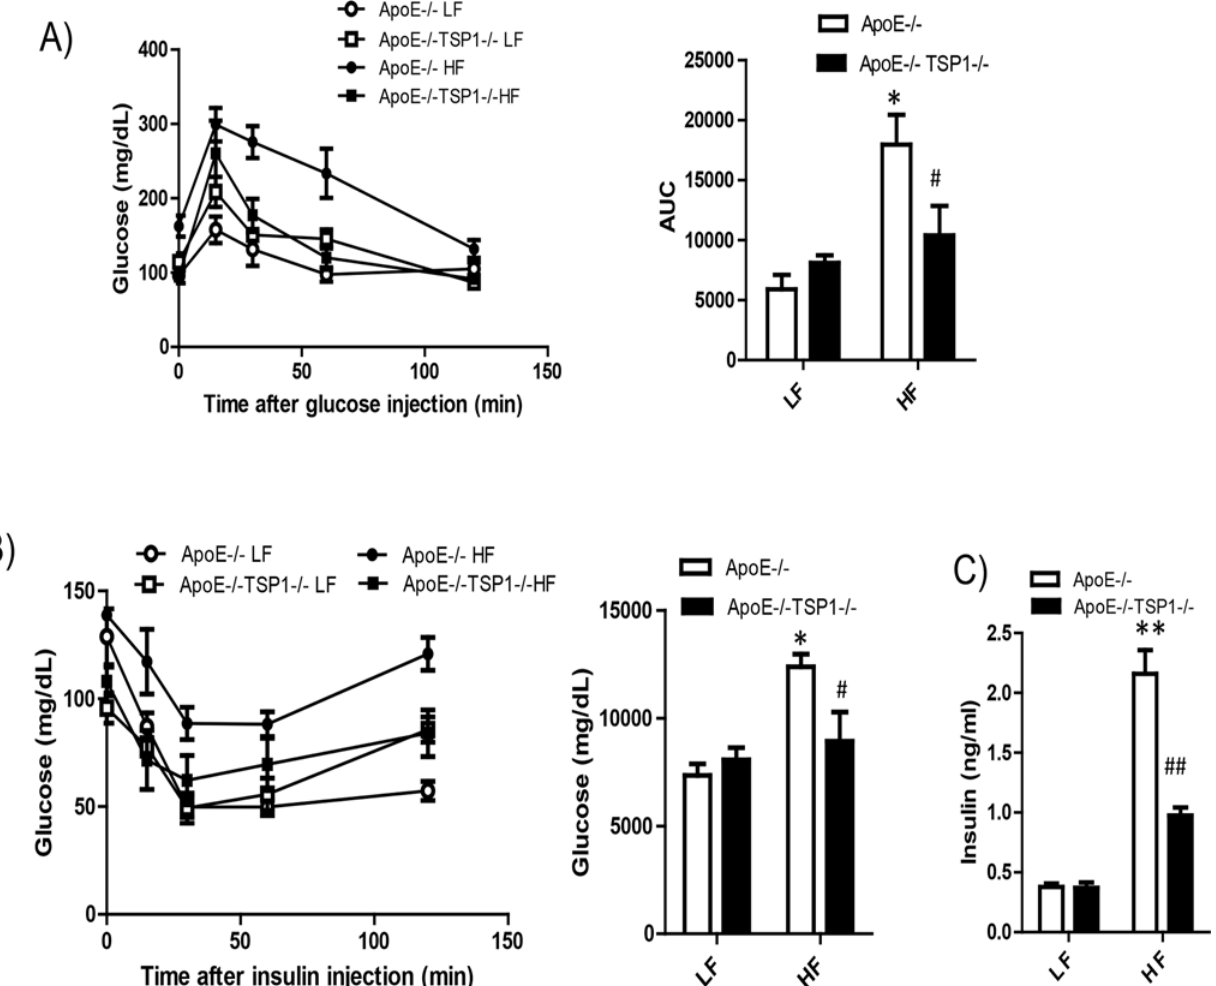
Fig 2. Obese ApoE-/-TSP1-/- mice had improved glucose tolerance and insulin sensitivity. Male ApoE-/-TSP1-/- mice and ApoE-/-mice were fed LF or HF diet for 16 weeks. Intraperitoneal glucose tolerance (A) and insulin tolerance test (B) were measured. Changes in blood glucose levels were monitored over time. C) Plasma insulin levels were measured by ELISA. Data are represented as mean ± SE (n = 10 mice/group). * P < 0.05 and ** P < 0.01 vs. LF ApoE-/-. # P < 0.05 and ## P < 0.01 vs. HF ApoE-/-. AUC: area under the